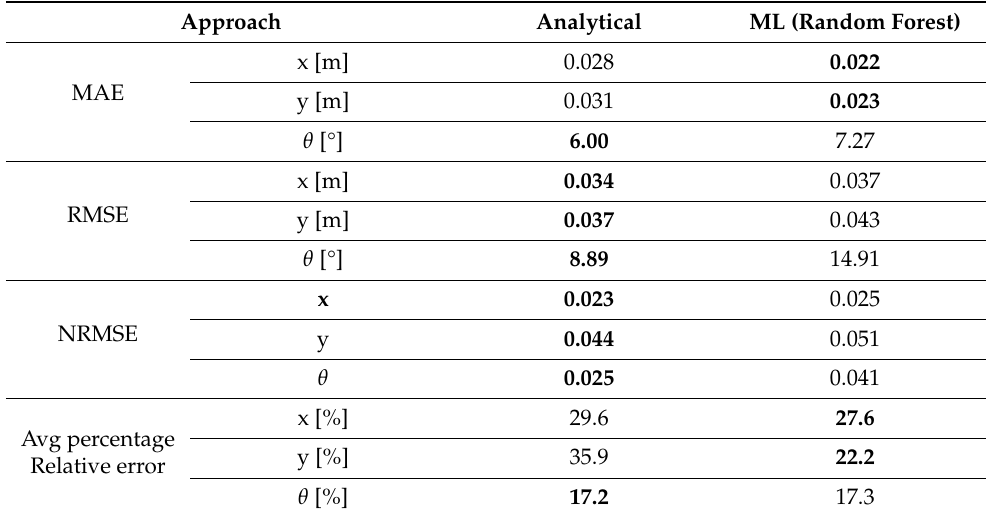
Table 4. Comparison 1 of the two approaches: analytical and ML (Random Forest). The bold values present the best values